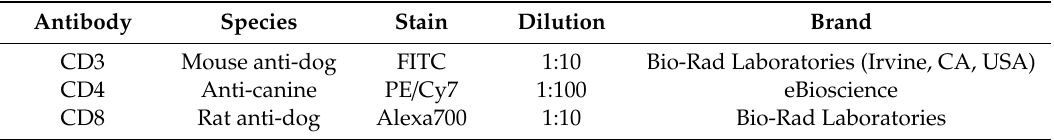
Table 2. Antibodies for cytokine intracellular